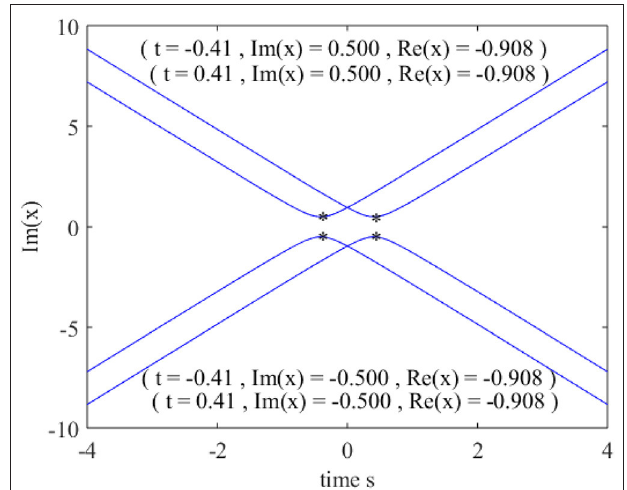
FIGURE 6 | Pole trajectories in the complex plane by allowing the variable x to be complex by analytic continuation. Poles occur at the zeros of D 00 of Equation (6). The real parts of the poles at the turning points of the trajectories coincide with the locations of maximum heights of the rogue wave in physical space.